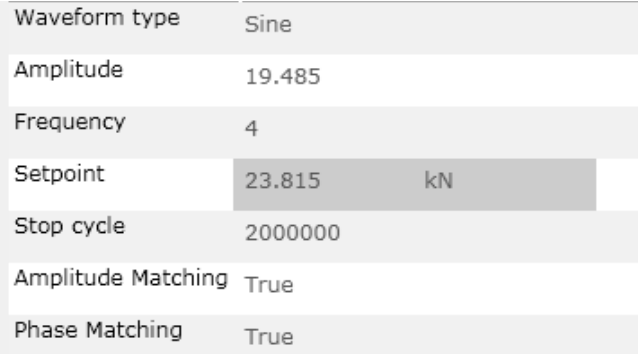
Figure 21. Fatigue loading and cycle setting.